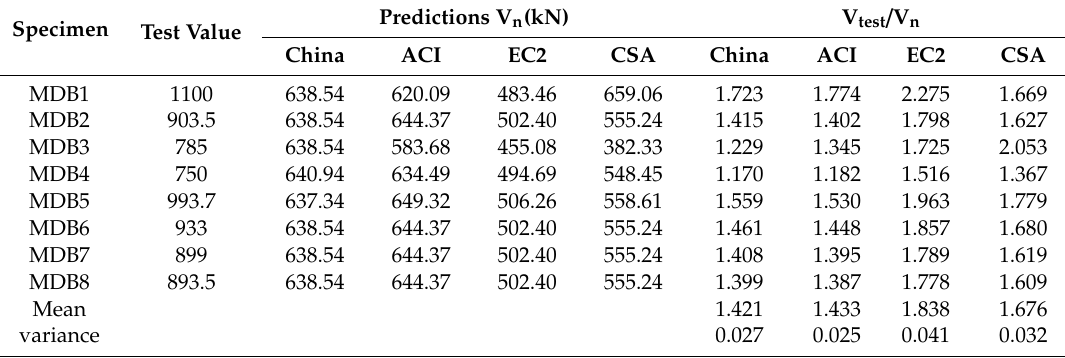
Table 5. Comparison of prediction values and experimental